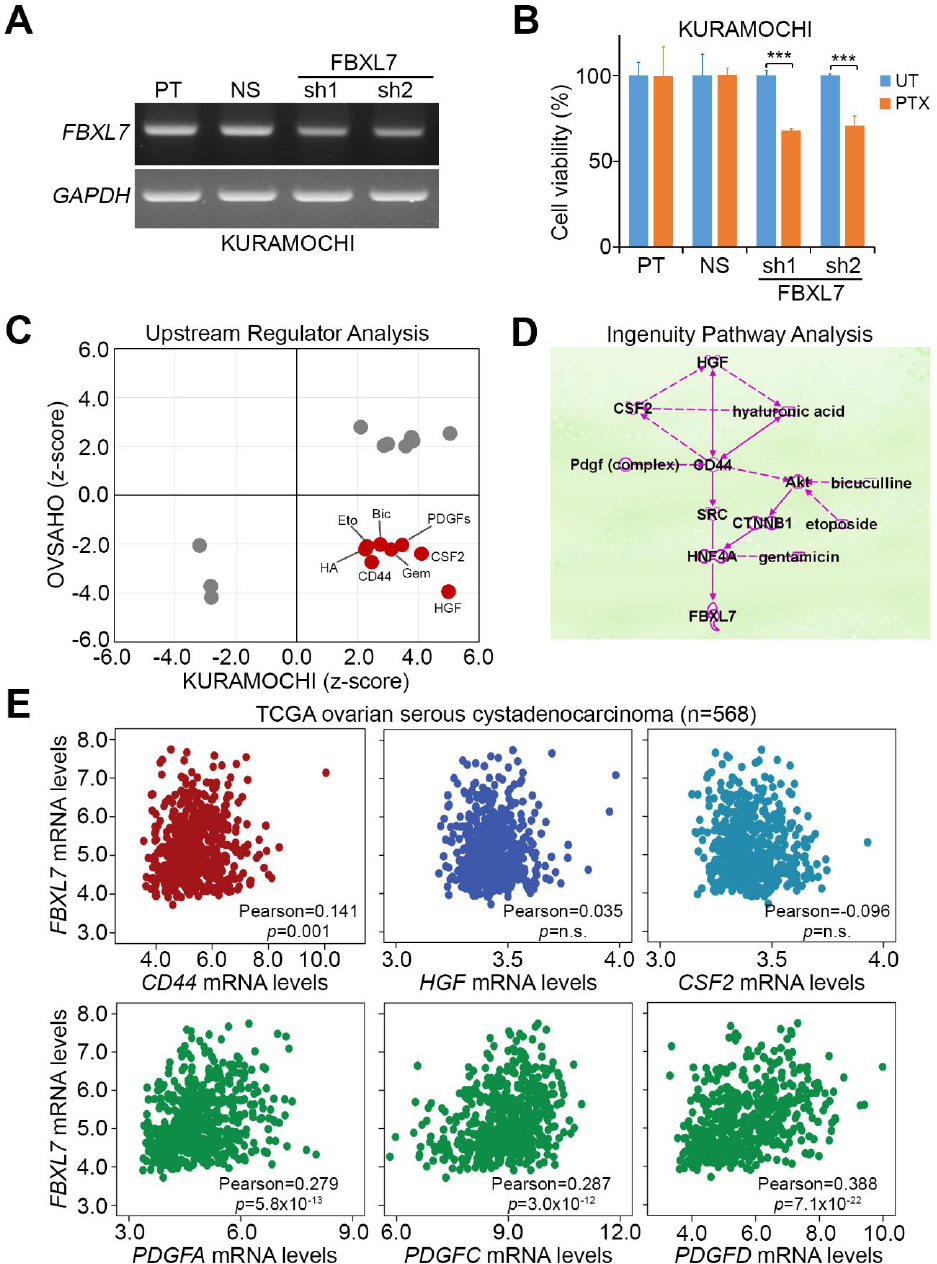
Figure 5. Possible mechanism underlying PTX resistance in ovarian cancer cells. ( A ) The mRNA levels of FBXL7 and GAPDH detected by RT-PCR experiment in parental (PT) KURAMOCHI cells transfected without or with non-silencing (NS) or 2 independent FBXL7 shRNA (sh) clones for 24 hours. GAPDH was used as an internal control of the experiment; ( B ) Cell viability measured by MTT assay in parental, non-silencing or FBXL7-silencing KURAMOCHI cells treated with PTX at 10× IC 50 concentration (60 nM). The symbol (***) denotes statistical significance at p < 0.001 in the Mann–Whitney U test; ( C ) The in silico analysis of consensus upstream regulators that are possibly activated or inhibited after PTX treatment at the concentration of 10× IC 50 for 24 hours in OVSAHO and KURAMOCHI cells using Ingenuity Pathway Analysis (IPA) software; ( D ) Interactions among the identified upstream regulators that are highly predicted to be activated in PTX-treated KURAMOCHI cells with PTX resistance using IPA simulation. Solid and dashed lines represent direct and indirect interactions, respectively, among the tested molecules; ( E ) Correlations among FBXL7 mRNA levels and the identified upstream regulators CD44 , HGF , CSF2 , PDGFA , PDGFC , and PDGFD in patients with ovarian serous cystadenocarcinoma using TCGA database. The statistical significance of correlations was analyzed by pearson’s